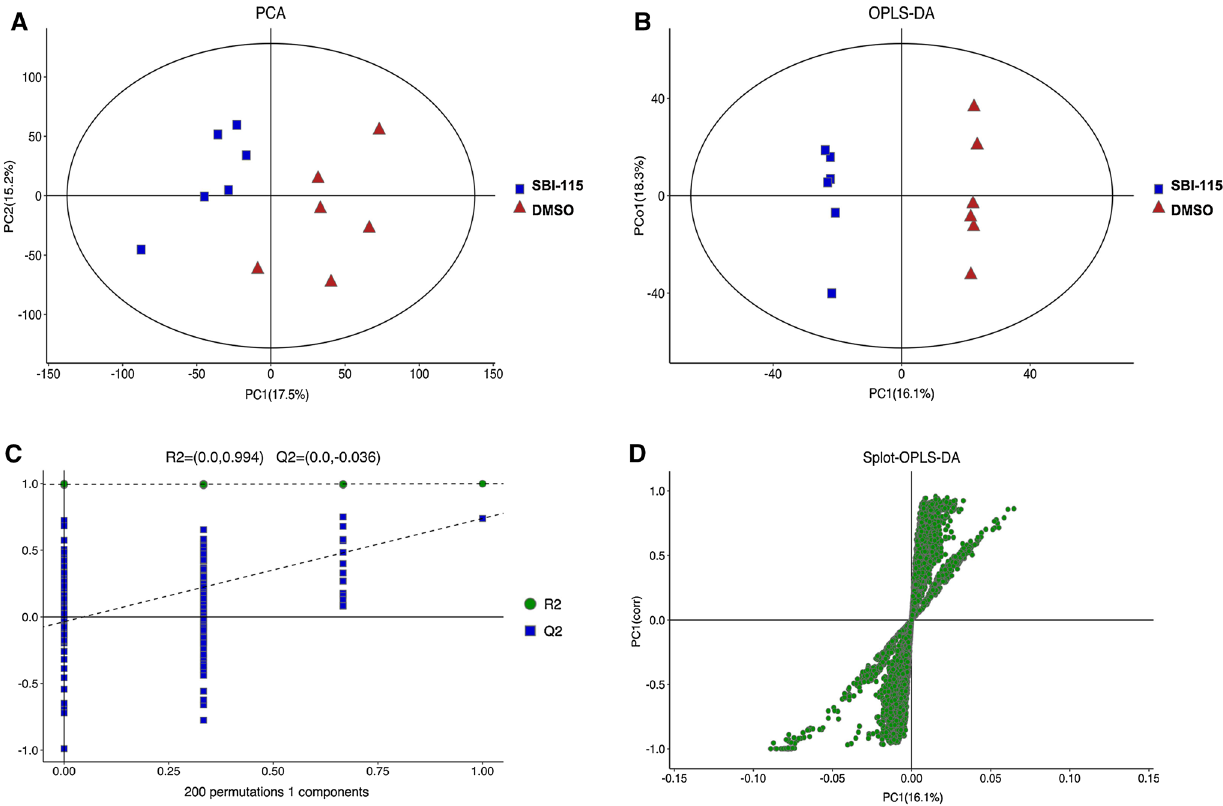
Fig. 5 The LC–MS based non-targeted metabolomics analyses in SBI-115-treated group and DMSO-treated group. A , B The PCA score plot and OPLS-DA score plot showed the differences in metabolic components were significant between the SBI-115-treated group and DMSO- treated group; C The permutation test (200 times) of the OPLS-DA model in the SBI-115-treated group and DMSO-treated group; D The S-plot derived from OPLS-DA demonstrated the accumulated differential metabolites in the SBI-115-treated-group and